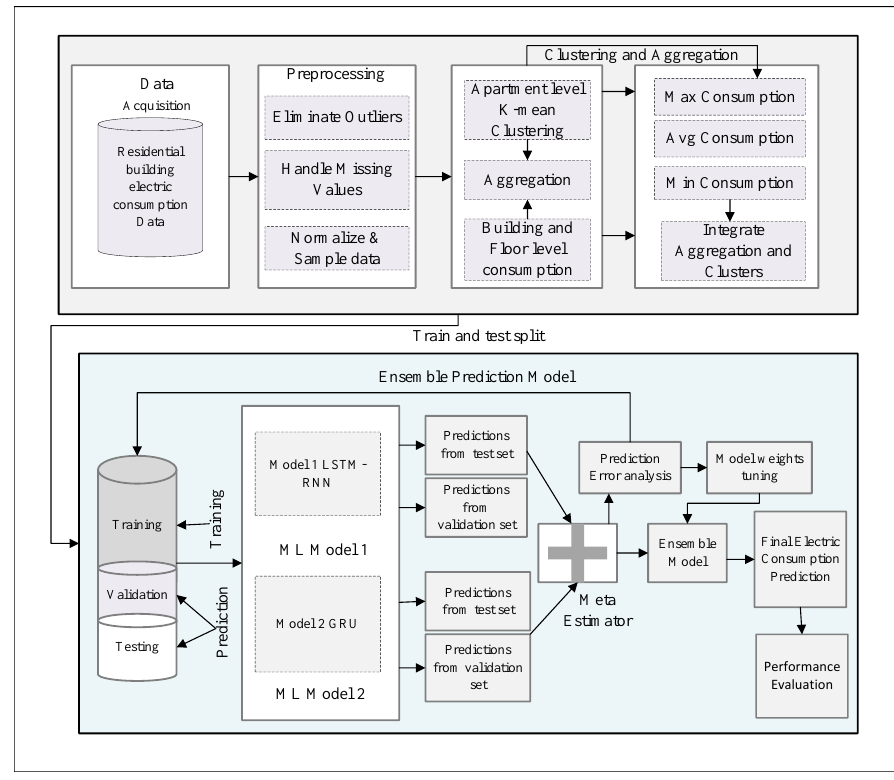
Figure 2. Ensemble Electric Consumption Forecasting Model based on LSTM and